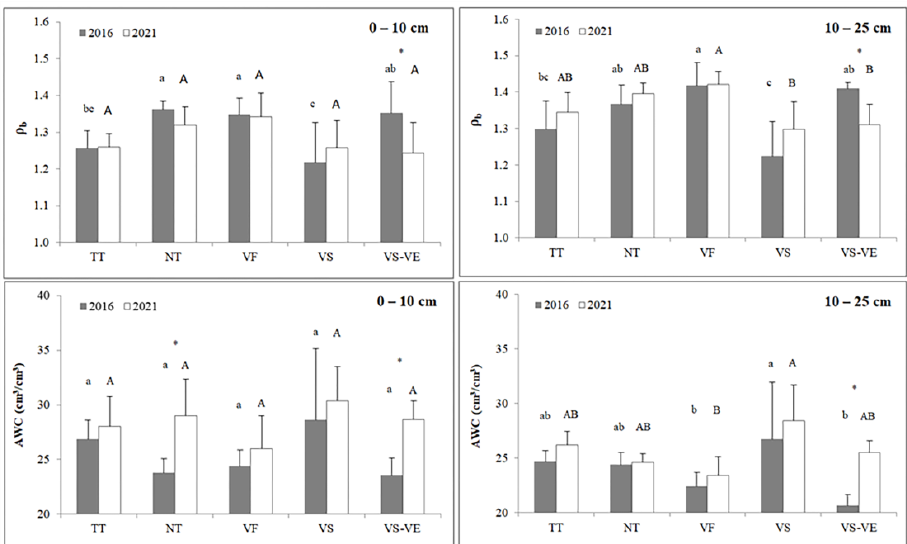
Figure 2. Average soil bulk density ( ρb ) and available water capacity (AWC) by effect of different soil management strategies. TT, traditional tillage; NT, no tillage; VF, cover of V. faba ; VS, cover of V. sativa ; VS-VE, cover of V. sativa and V. ervilia . Numerical values are means, bars are standard deviation. Different lowercase letters indicate significant differences between management strategies at the beginning of the study; different capital letters indicate significant differences between management strategies at the end of the study; *, indicates significant differences in management strategy between the two periods by Tukey’s test, p < 0.05.